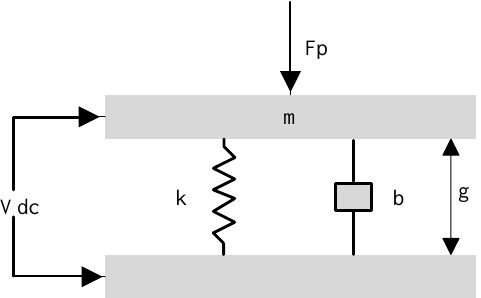
Figure 3. Parallel plate capacitance model (received).